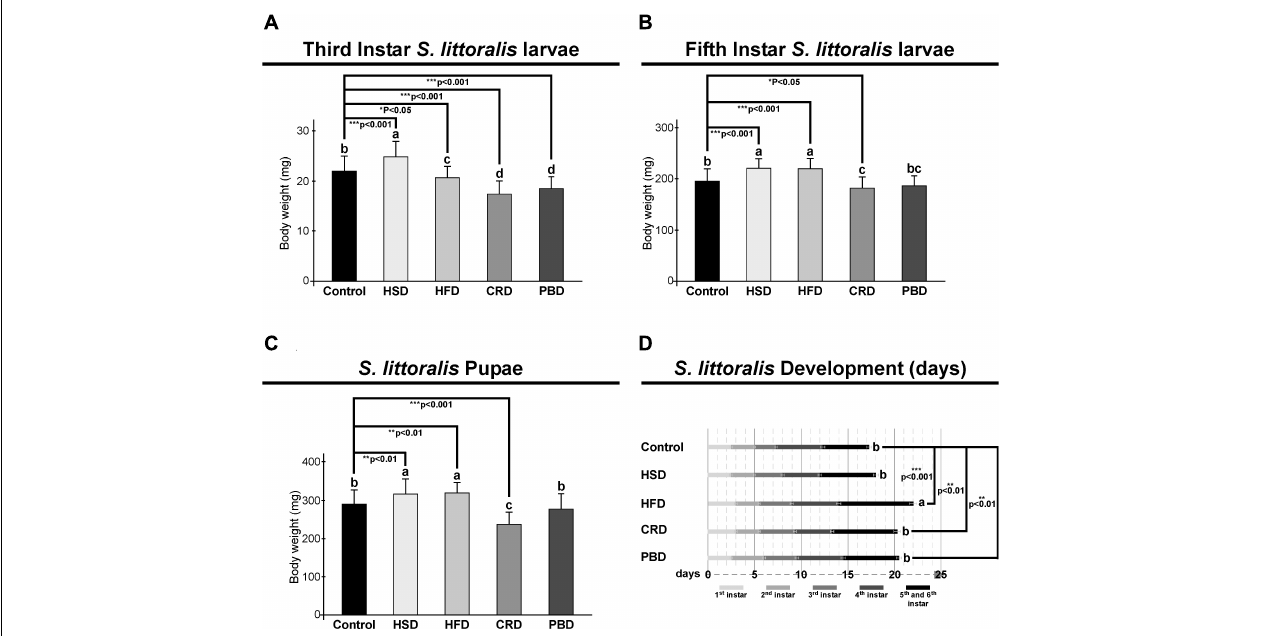
FIGURE 1 | Effects of different diet treatments on the larval and pupal weights, and development of Spodoptera littoralis . Body weights at third (A) , fifth instar (B) larvae, and pupa (C) , and larval development durations (D) are shown. Statistical significances in the entire sample set were determined by using one-way ANOVA, followed by a Tukey HSD test (groups associated with different letters are significantly different from each other, P < 0.05). A t -test was used for binomial comparisons (diet treatment vs control) (* p < 0.05, ** p < 0.01, and *** p < 0.001 indicate the statistical differences between the particular diet and the control). Values are expressed as means ± standard error. Control, Regular artificial bean diet; HSD, High sugar diet; HFD, High fat diet; CRD, Calcium-rich diet; PBD, Plant-based diet.